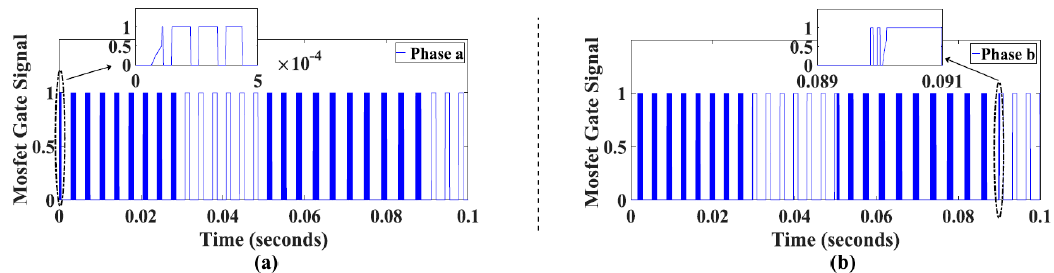
Figure 12. Gate control signal for combined “with and without an R-C filter” methods: (a) During start-up phases. (b) During set point change occurrence.